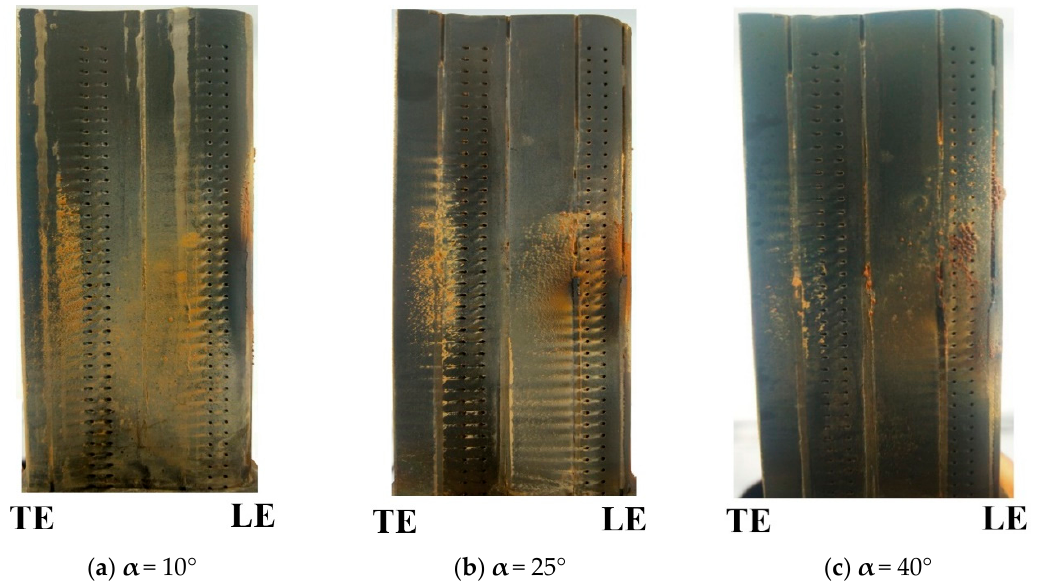
Figure 19. Images of the post-test blade pressure side at the angle of attack: ( a ) 10°, ( b ) 25°, and ( c ) 40°.